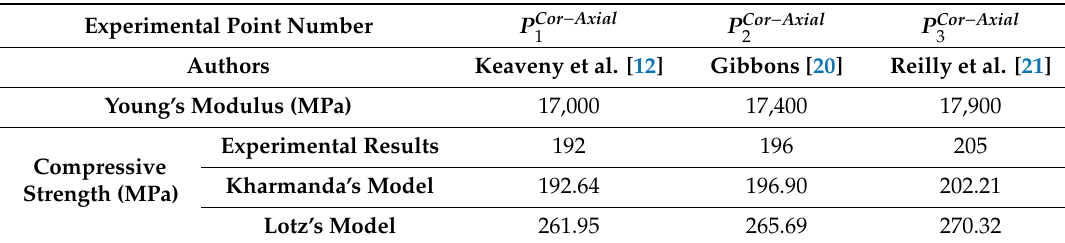
Table 2. A comparison of experimental compressive stress with Kharmanda’s and Lotz’s models in the axial direction.